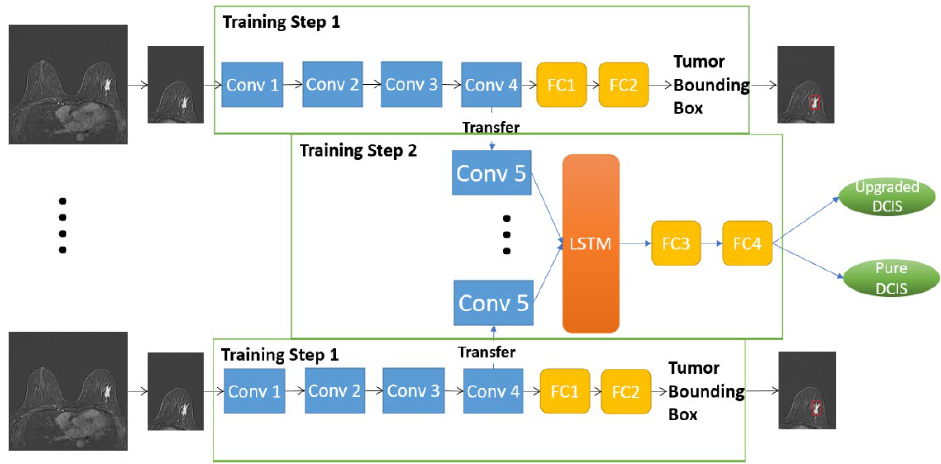
network in the second step.